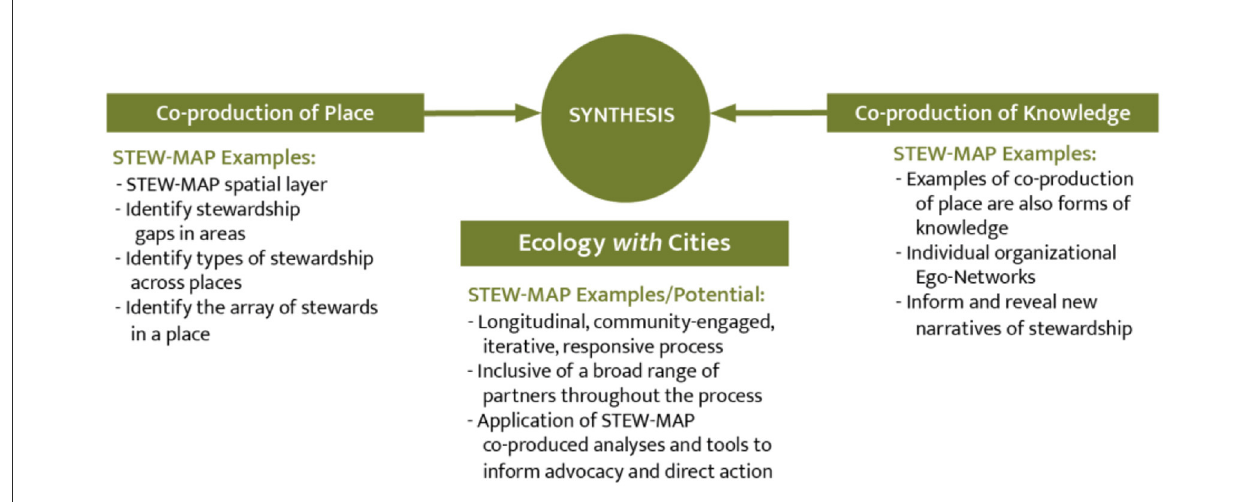
FIGURE2 Conceptualization of STEW-MAP as an ecology with cities approach (adapted from Pickett et al.,